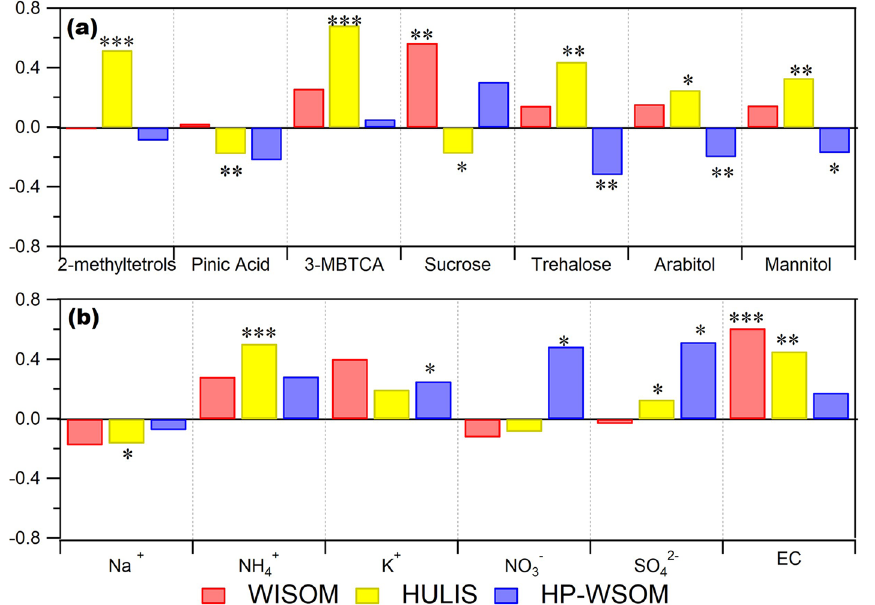
Figure 2. Pearson’s correlation coefficients ( n = 18) and significance levels (*: < 0.05, **: < 0.01, ***: < 0.001) from the correlation analysis of the mass concentrations of WISOM, HULIS, and HP-WSOM and those of ( a ) biogenic molecular tracers and the analysis of ( b ) inorganic ions and EC.